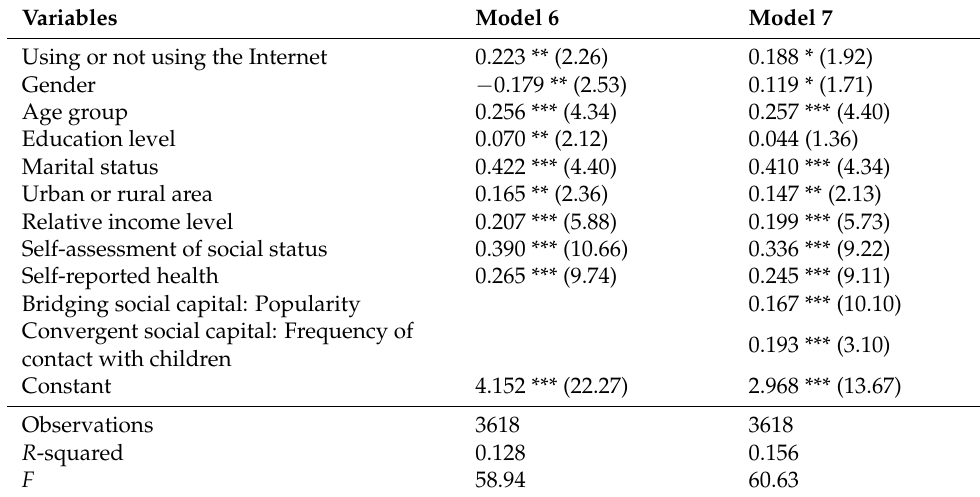
Table 3. Endogeneity